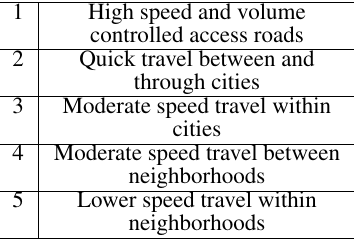
Table 2. Road category (Source: Digital Map Technology, 2017) The road category is important for the consideration of parking cars along the road in residential areas. Vehicles in those areas receive a special weighting within the fuzzy system. For the definition of the membership function, the road categories 1 − 2 are merged in strong traffic roads and the other categories 3 − 5 in low traffic roads.